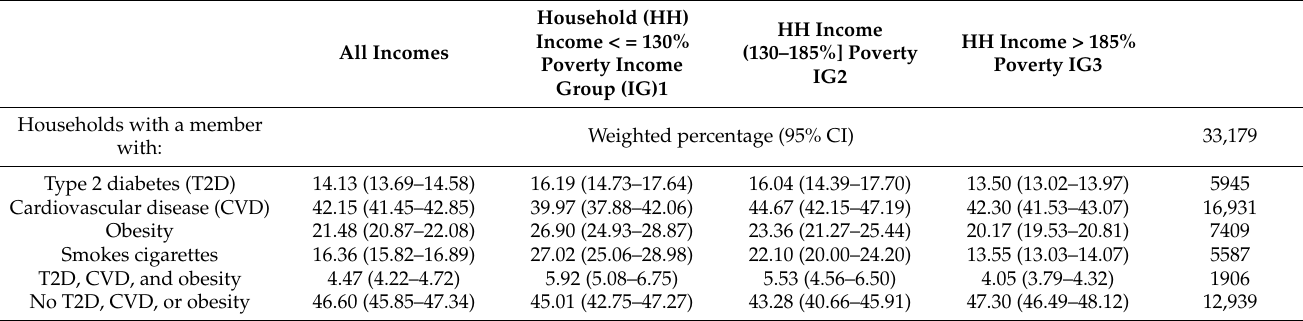
Table 2. Percentage of households with a member with one or multiple health outcomes, based on IRI MedProfiler 2015